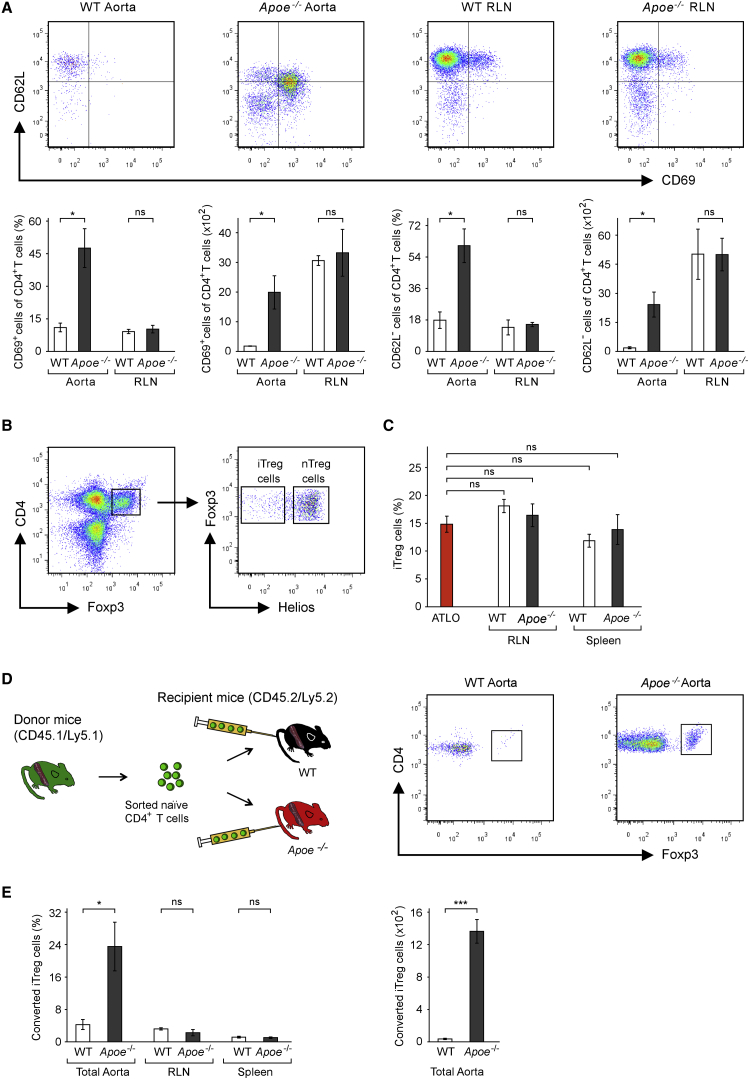
ATLOs Prime Naive CD4+ T Cells and Convert Some of Them into iTreg Cells(A) Activation of naive CD4+ T cells in situ. 78- to 85-week-old Apoe−/− or WT mice were splenectomized and FTY720-treated as described in Figure 3A. Ly5.1 cells were analyzed by flow cytometry at 24 hr in total aortas or RLNs for CD62L and CD69 expression (upper panel), and their absolute numbers and frequencies among recruited cells (lower panel) (see also Figures S5).(B) nTregs and iTregs in ATLOs. CD4+Foxp3+ Treg cells in ATLOs were analyzed for Helios expression.(C) Frequencies of iTreg cells in total CD4+Foxp3+ Treg cells.(D) Conversion of naive CD4+ cells into iTregs. Experimental approach to determine naive CD4+ (CD4+CD62L+CD69−CD25−CD44−) T cell conversion into iTreg cells (left), and flow cytometry shows the converted Foxp3+ iTreg cells from the transfer cell gate after 3 weeks.(E) Quantification of converted iTreg cells from migrated naive CD4+ T cells 3 weeks after transfer. Data are representative of three (A, D, and E), or four (B and C) experiments with one mouse per genotype per experiment. Two-tailed Student’s t test for (A) and (E); two-tailed Wilcoxon-Mann-Whitney test corrected for multiple testing (Bonferroni) for (C). ∗p ≤ 0.05, ∗∗p ≤ 0.01, ∗∗∗p ≤ 0.001.